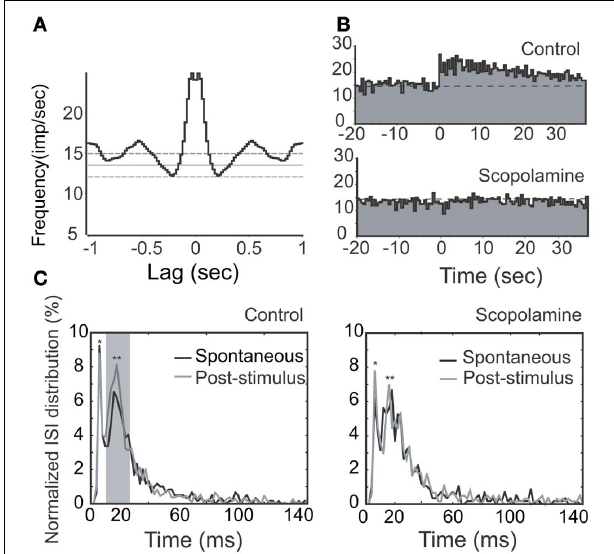
FIGURE 8 | Effects of stimulation (100 µ s, 500 µ A, 100Hz, 25 pulses) and scopolamine on a rhythmic unit with long-lasting NDB potentiation. (A) Autocorrelation of spontaneous spikes; Bin = 20ms. (B) Histogram of NDB-induced spike rates before and after scopolamine administration (IP, 7.5mg/kg). (C) ISI distributions are shown before (left) or after (right) scopolamine treatment, respectively. Note that this unit has a typical ISI range of 12–25ms ( ∗∗ ). It also has a faster characteristic spiking with an ISI range of 3–12ms ( ∗ ). Note that ISIs following NDB stimulation are decreased ( p < 0 . 005), which is not changed significantly with scopolamine ( p > 0 . 5).